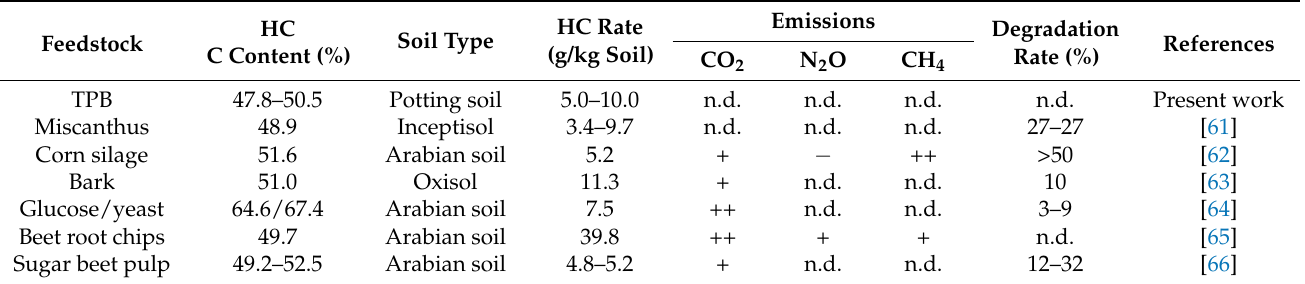
Table 5. Summary on hydrochar soil amendment at different experimental conditions using different biomass feedstock